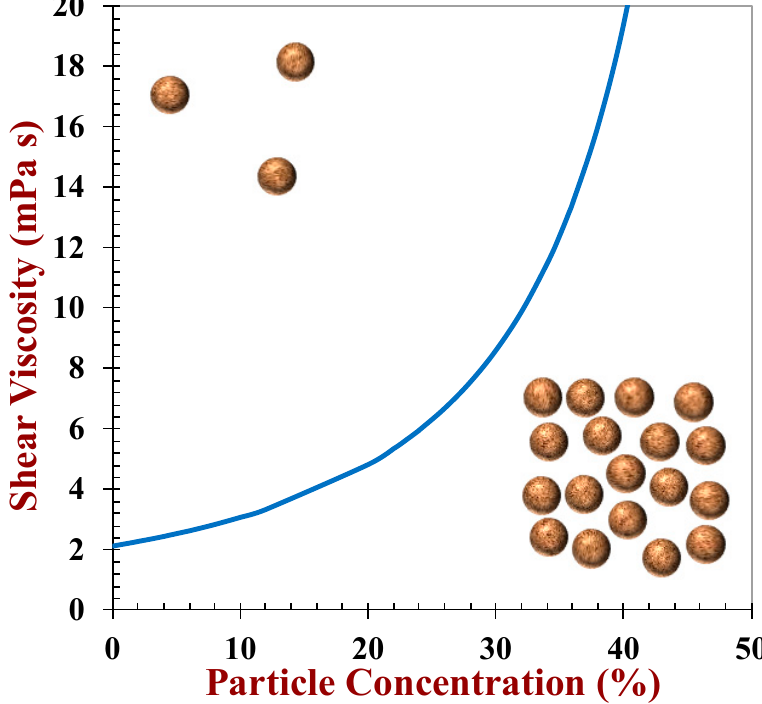
Figure 3. The shear viscosity of plant-based milks depends on the concentration of particles they contain, such as oil bodies or fat droplets. The viscosity may also be increased by adding thickening agents. The theoretical predictions were made by the author using effective medium theory for oil droplets suspended in water.